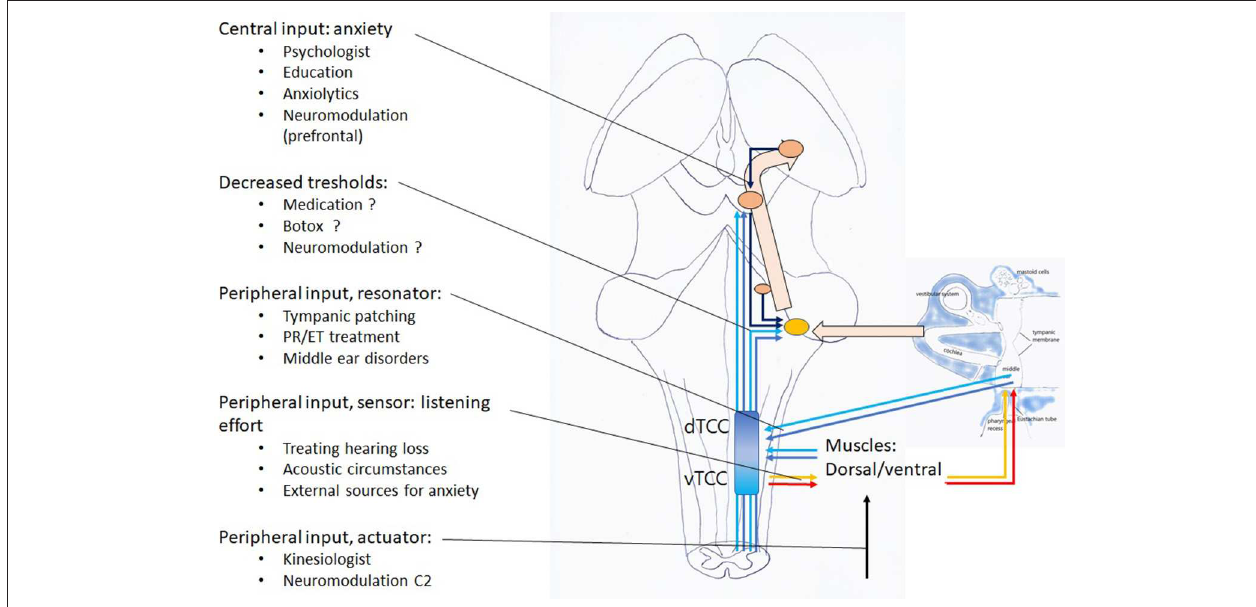
FIGURE 12 | Treatment